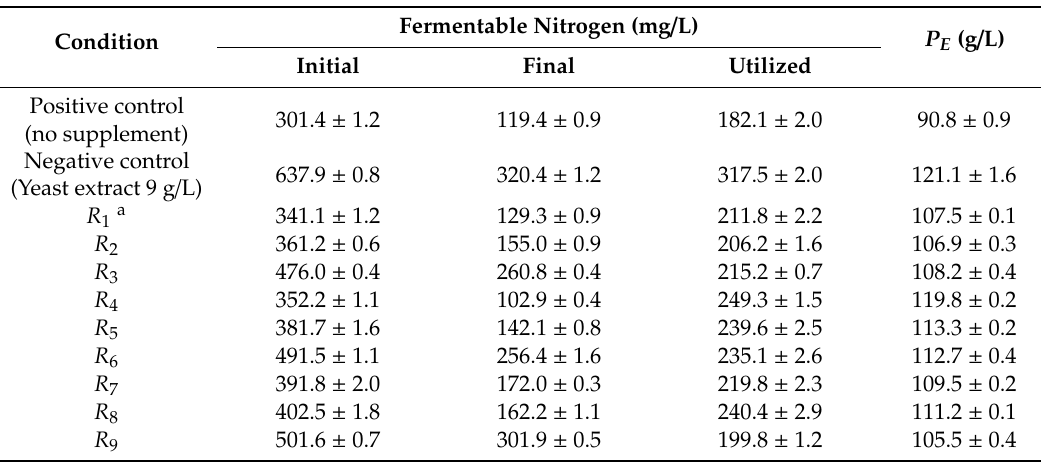
Table 4. Fermentable nitrogen during ethanol production from the sweet sorghum juice under various nutrient